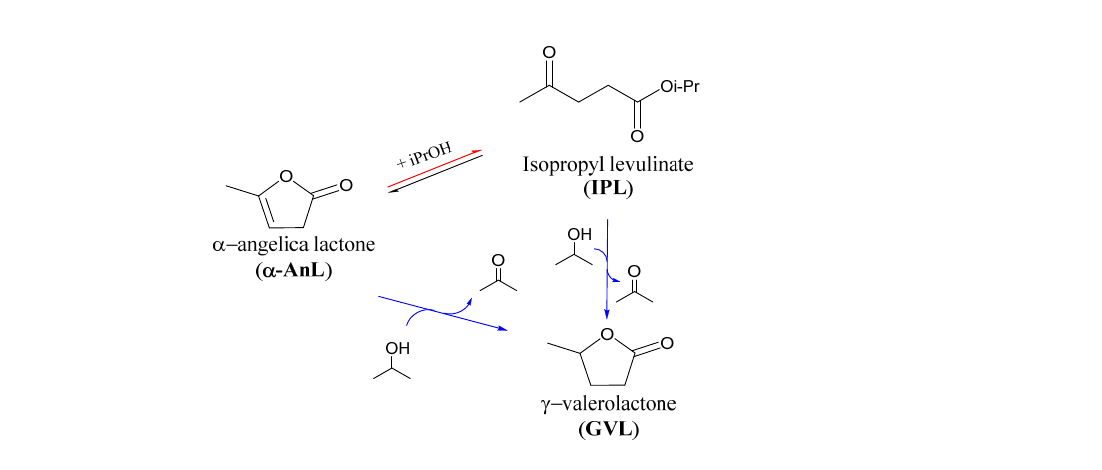
Figure S3: (a) N 2 adsorption − desorption isotherms and (b) pore size distribution of Ti/Zr/O (1:1) before and after (SPENT) reaction; Figure S4: Furfural conversion and product selectivities (%) as a function of time (h) using SiC. Reaction conditions: [FU] = 67 mM, τ = 10 min, T = 180 ◦ C, m cat = 0.75 g; Figure S5: Furfural conversion and product selectivities (%) as a function of time (h) using ZrO 2 . Re- action conditions: [FU] = 67 mM, τ = 10 min, T = 180 ◦ C, m cat = 0.86 g; Figure S6: Furfural conversion and product selectivities (%) as a function of time (h) using TiO 2 . Reaction conditions: [FU] = 67 mM, τ = 10 min, T = 180 ◦ C, m cat = 0.97